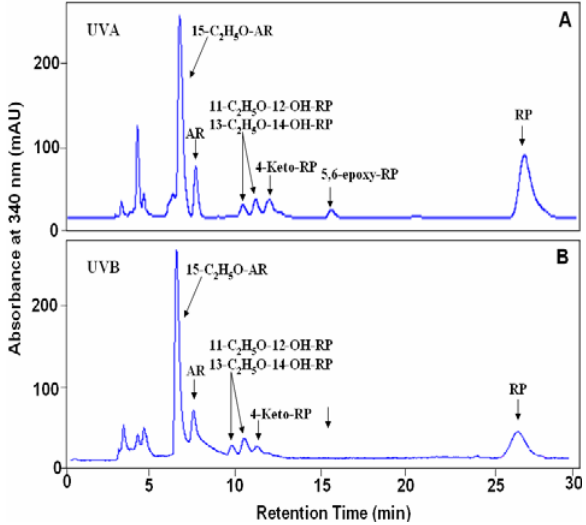
Figure 3: Reversed-phase HPLC profile of the photodecomposition products of RP (0.5% in ethanol) after irradiation with 14 J/cm 2 of (A) UVA or (B) UVB light. HPLC analysis was conducted on a Prodigy 5 µ ODS column (4.6 x 250 mm) eluted isocratically with methylene chloride in methanol (1/9; v/v) at 1 mL/min.